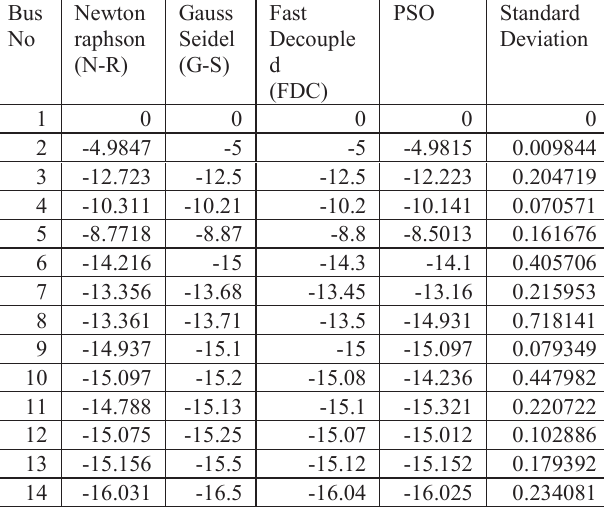
Table 2. Comparison of result